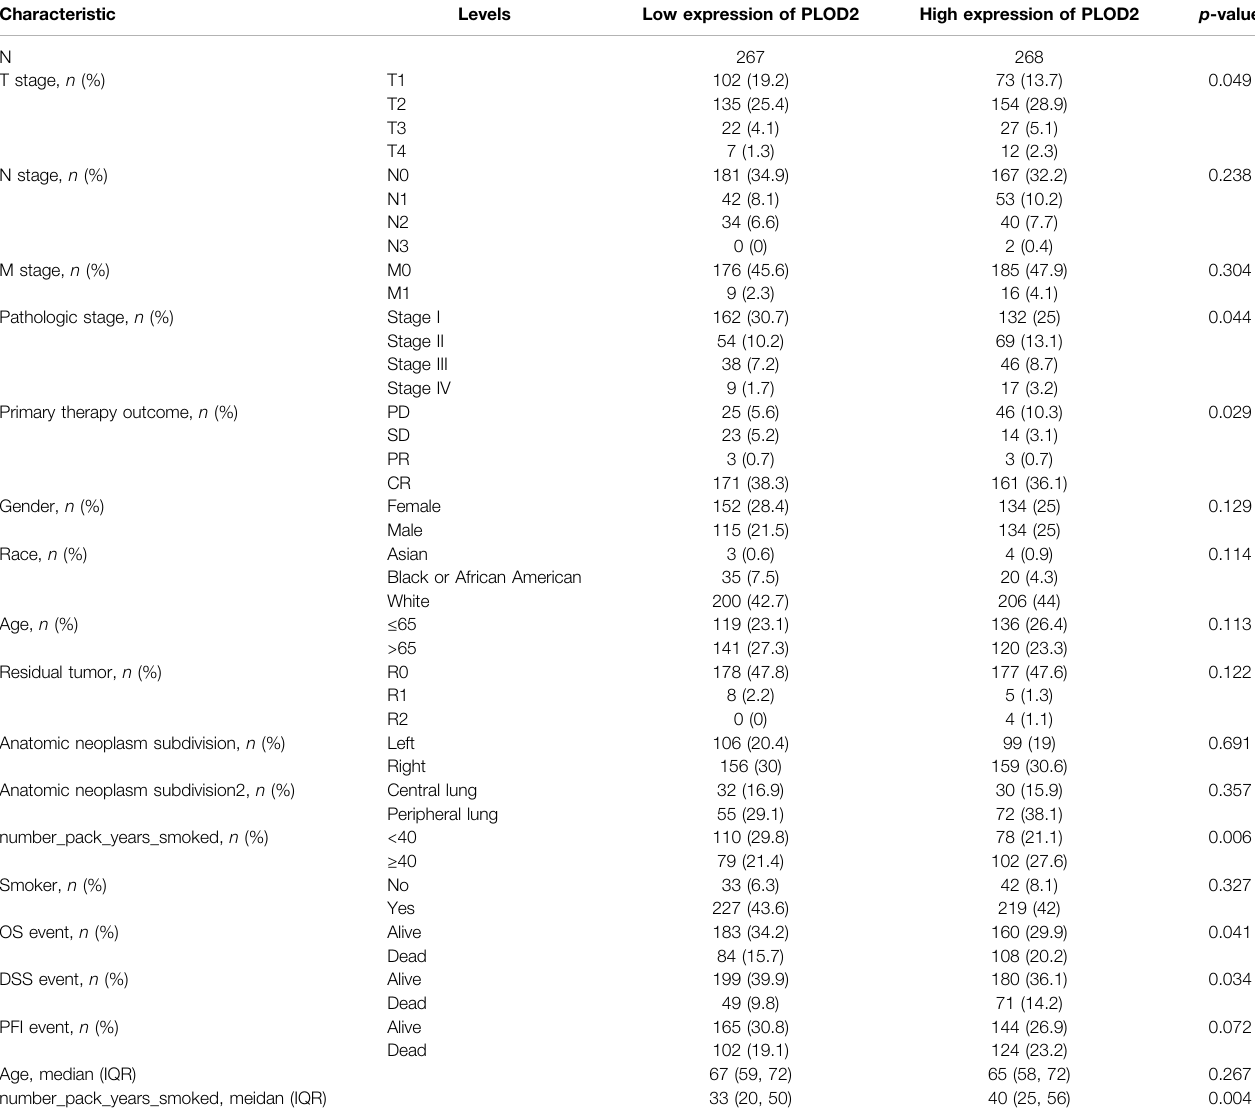
TABLE 2 | Clinical characteristics of the LUAD patients (TCGA) Characteristic Levels Low expression of PLOD2 High expression of